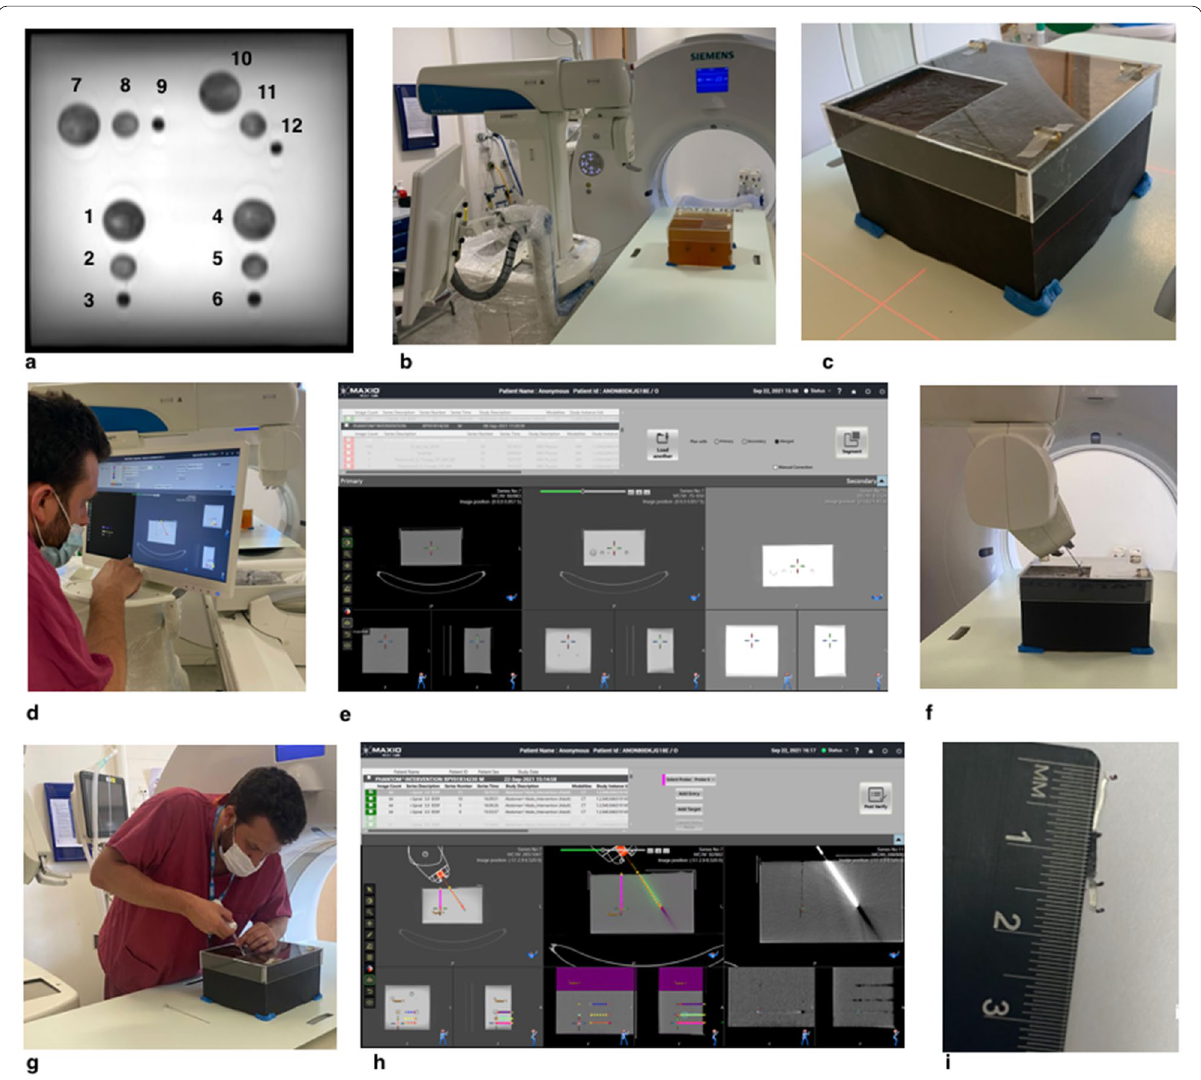
Fig. 3 a Coronal/birds‑eye on T2‑weighted turbo spin‑echo images with numbered targets. b Phantom on the CT table next to the robot. c Aligned phantom, fixed with adhesive putty. d MRI/CT‑fusion and needle path planning using robot workstation. e Workstation screenshot showing CT (left), fused MR/CT (middle), and MRI (right) reference points. f Robot and inserted co‑axial needle. g Radiologist performing a biopsy. h Robot workstation showing planned (left), actual (right), and fused (planned and actual, middle) needle paths. i Biopsy core with target (black) and non‑target surround (very pale yellow); core length and target length are being measured. CT Computed tomography, MRI Magnetic